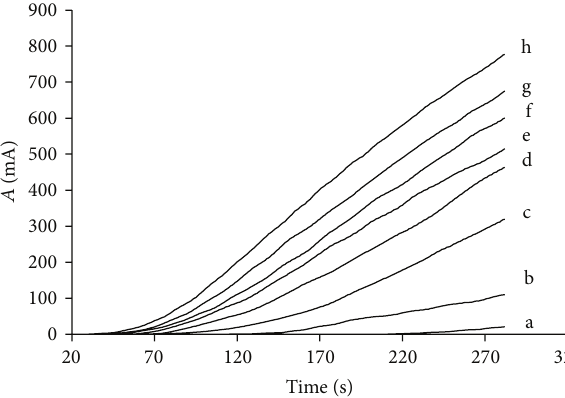
Figure 6: Stopped flow injection peaks for pectin calibration standards corresponding to following methanol concentrations: (a) 0 mM,(b)0.49mM,(c)1.4mM,(d)2.6mM,(e)3.4mM,(f)4.0mM, (g) 5.2 mM, (h) 6.3 mM, and (i) 7.2mM. Absorbance presented in